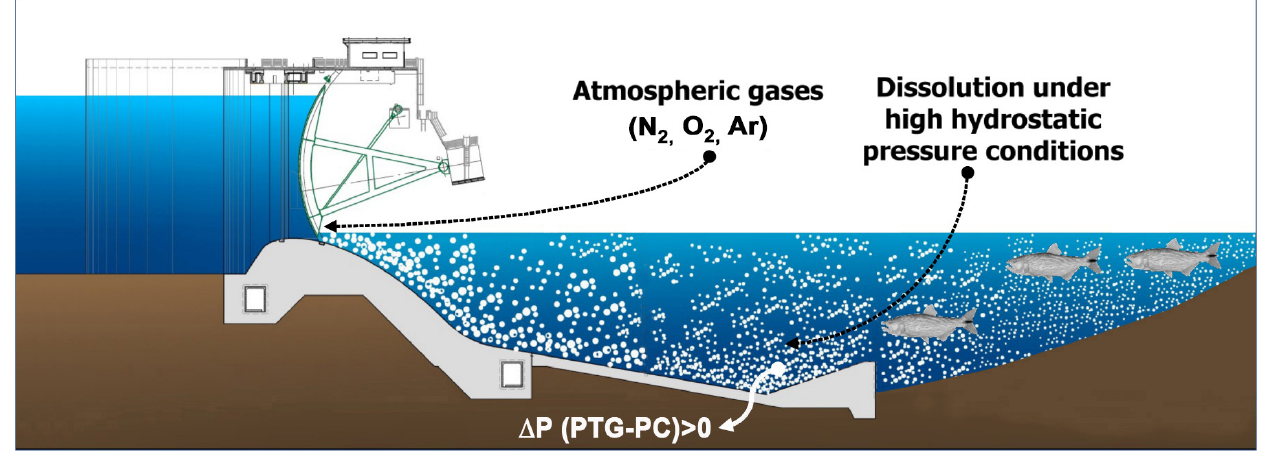
FIGURE 1 | Processes involved in gas supersaturation at downstream a spillway. PTG = Total gas pressure, PC = Compensation Pressure (barometric + hydrostatic) – (modified from Abernethy et al .,